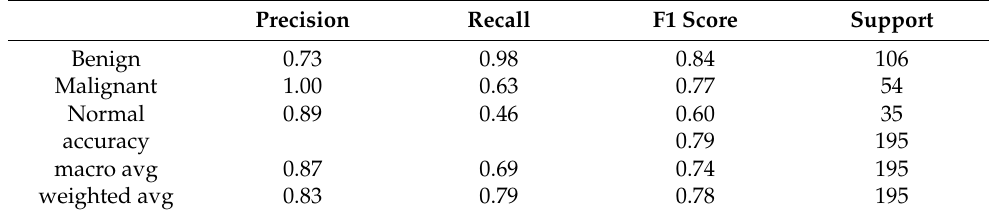
Table 3. Precision, Recall, and F1 score for the original image on 25% of test data.